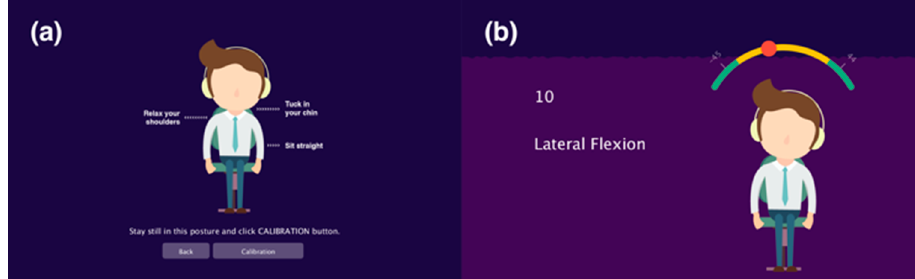
Figure 6. User interface of ( a ) device calibration and ( b ) exercise.